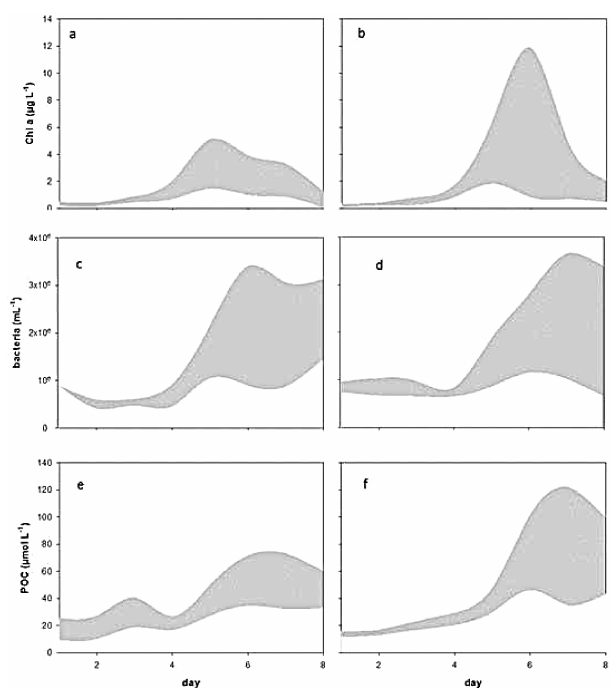
Figure 1. Bloom development during two series of mesocosm ex- periments, one with varied supply of PO 3 − ( Varied P ; a , c , e ; 4 n = 16) and one with NO − ( Varied N ; b , d , f ; n = 16). Shaded areas 3 indicate the range (min–max) of data observed during both treat- ments for Chl a concentration (a, b) , bacterial abundance (c, d) and particulate organic carbon (POC) concentration (e, f)